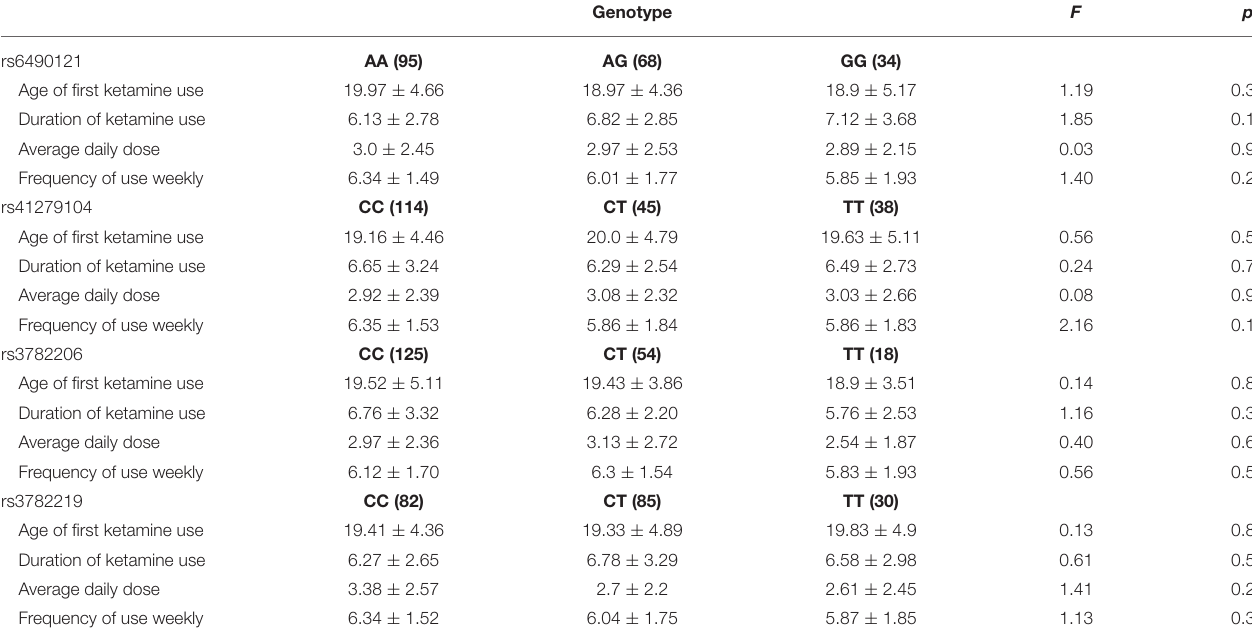
TABLE 5 | Association between drug use characteristics and genotypes of four NOS1 SNPs in ketamine